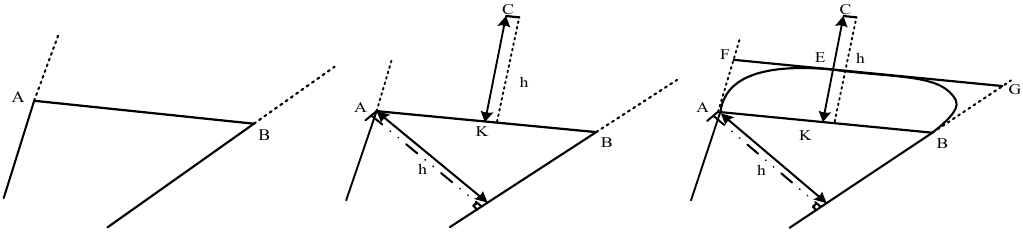
Figure 21. Construction process for the stratum boundaries of box